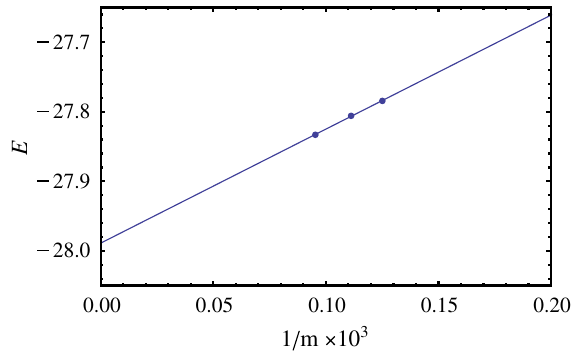
FIG. 18. DMRG energy of Hubbard model with U=t ¼ 6 on 32-site sample, as function of limiting MPS matrix size m